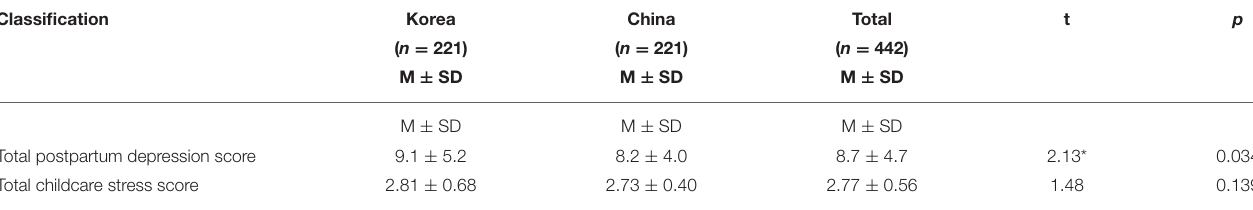
TABLE 4 | Comparison of postpartum depression score and childcare stress score among Korean and Chinese postpartum women. Classification